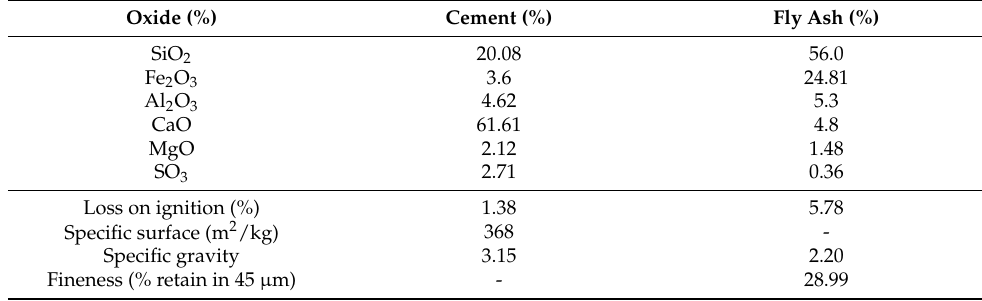
Table 1. Characteristics of cement and fly